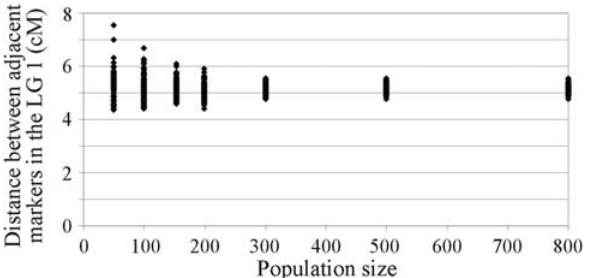
Figure 2 - Dispersion of the distance between adjacent markers in linkage group 1 (LG 1) as a function of population size, simulated using a genome with marker saturation level of 5 cM. Evaluation was done using only the replications that led to the formation of 11 linkage groups.